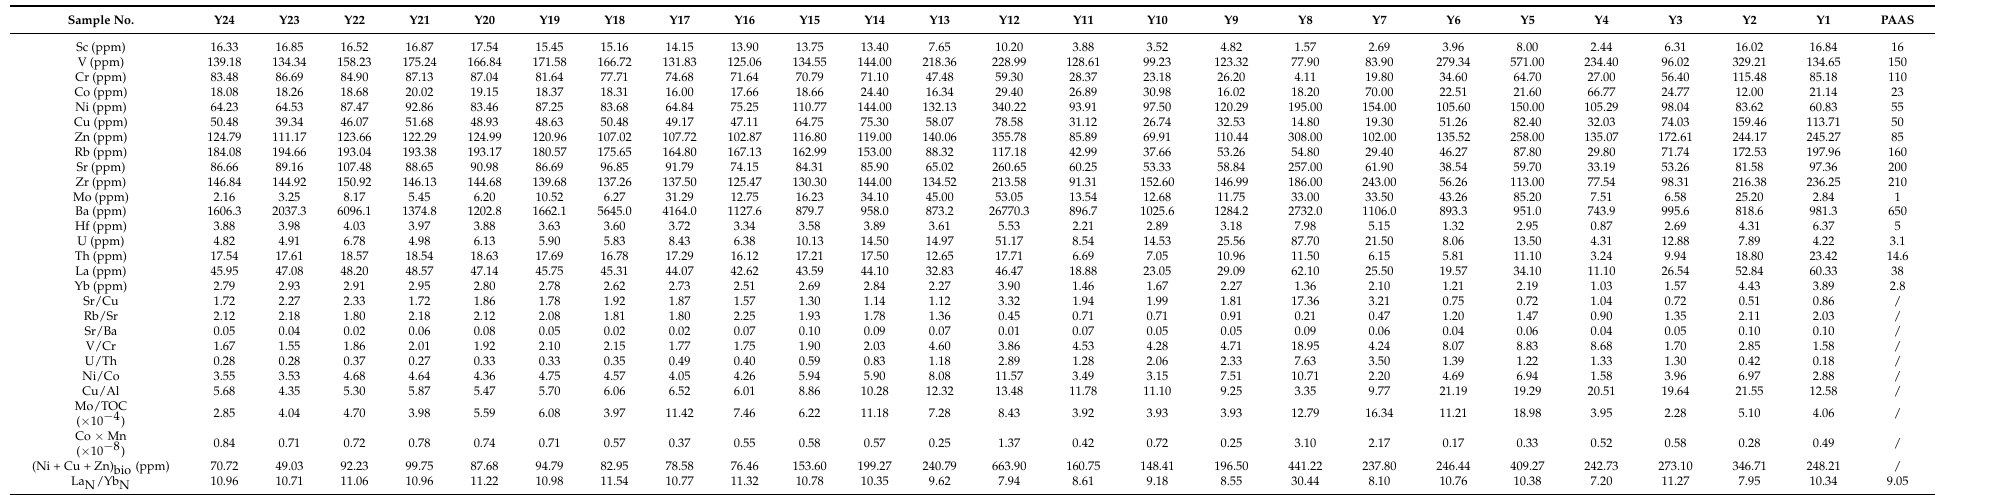
Table 2. Trace elements contents of the Wufeng–Longmaxi Formation in well YD1.